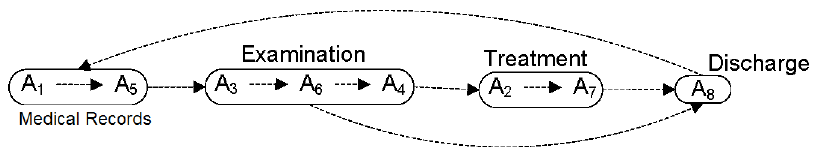
Figure 11. Nurse state model